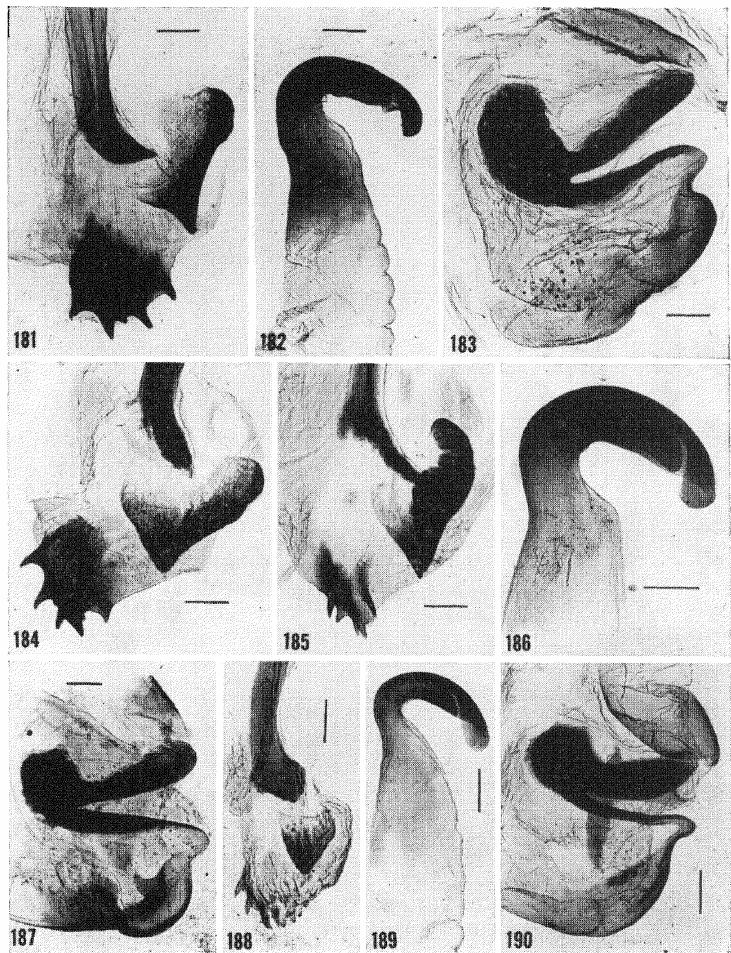
Figs. 181-190. 181-183. (14 MCZ). Hormetica apolinari. (from specimen shown in Fig. 165). 184. (2 ANSP). Hormetica alolinari. (from specimen --- shown in Fig. 164). 185-187. (44 CUZM). Hormetica .errucosa. (from specimen shown in Fig. 167). 188-190. (4 ANSP). Hormetica subcincta. (from specimen shown in Fig. 166). (scale 0.3